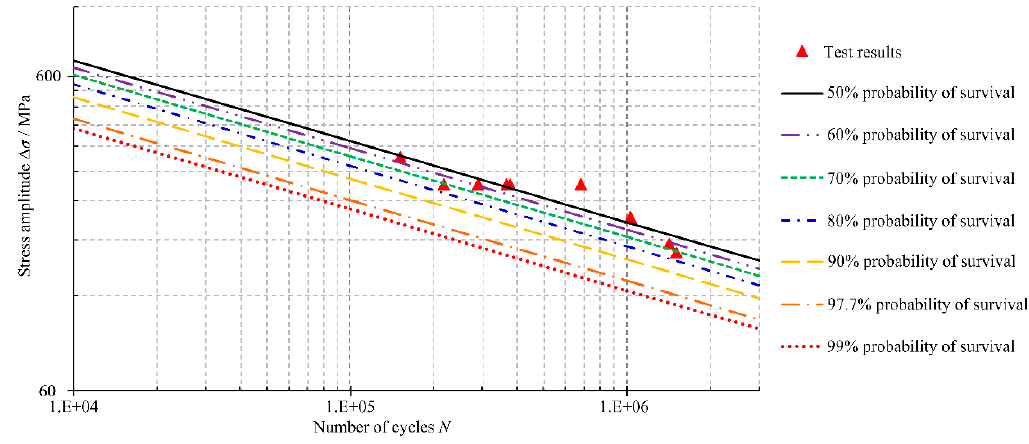
Figure 2. The curves of Δσ -N.